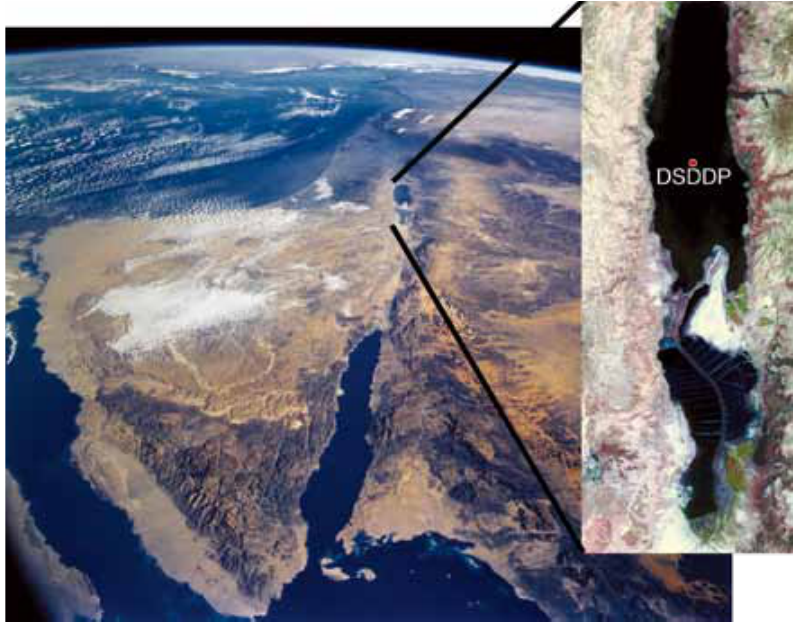
Figure 1. The Dead Sea basin and the location of the ICDP-DSDDP drilling